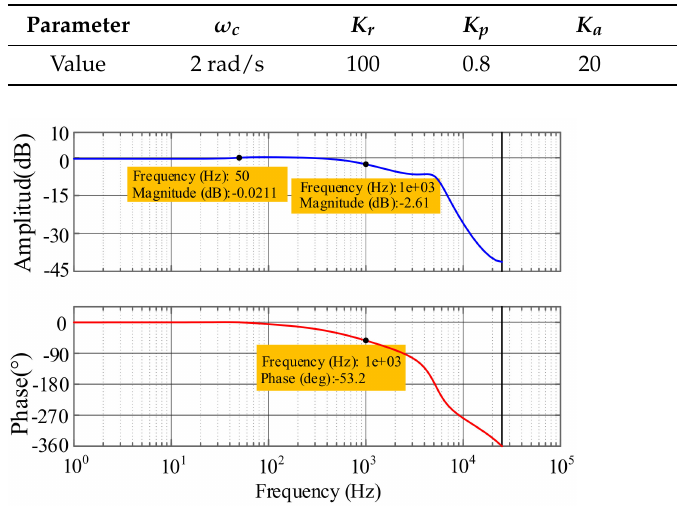
Table 2. PR Controller Parameters.